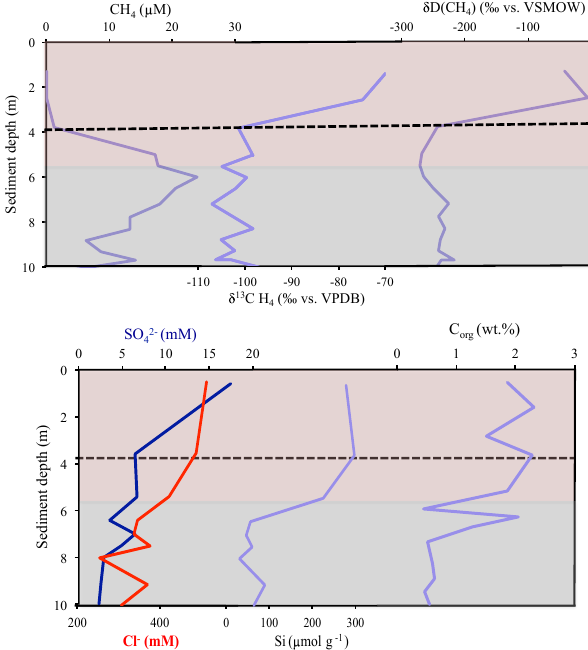
Figure 5. Close-up of the CH 4 concentration, stable isotope and other biogeochemical data of the surface of the non-ebullition sedi- ment core ID-11, from the Buor-Khaya Bay. Red shaded area corre- sponds to the marine sediment deposited during the Holocene trans- gression and the grey shaded area corresponds to the thawed per- mafrost layer. The black dotted line corresponds to the depth where CH 4 oxidation starts to